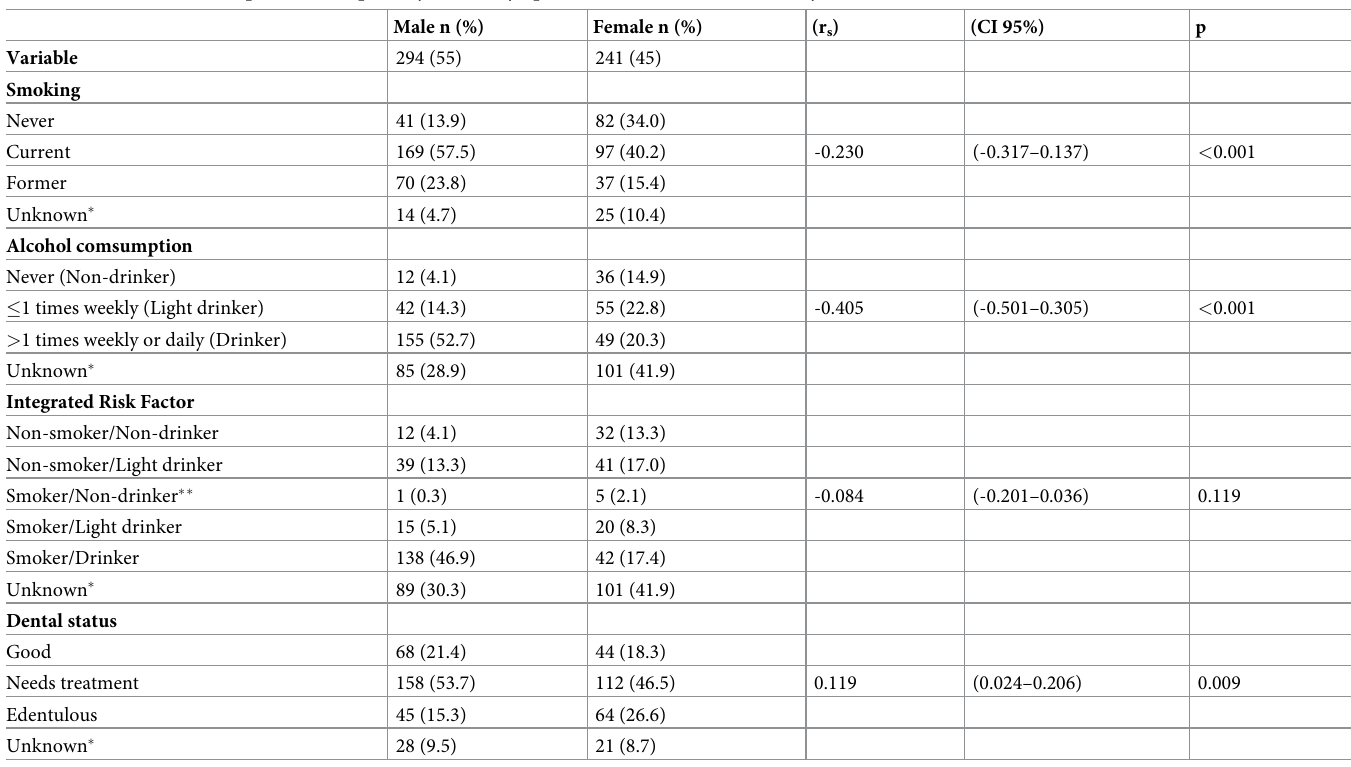
Table 2. Risk factors for 535 patients with primary oral cavity squamous cell carcinoma in Norway